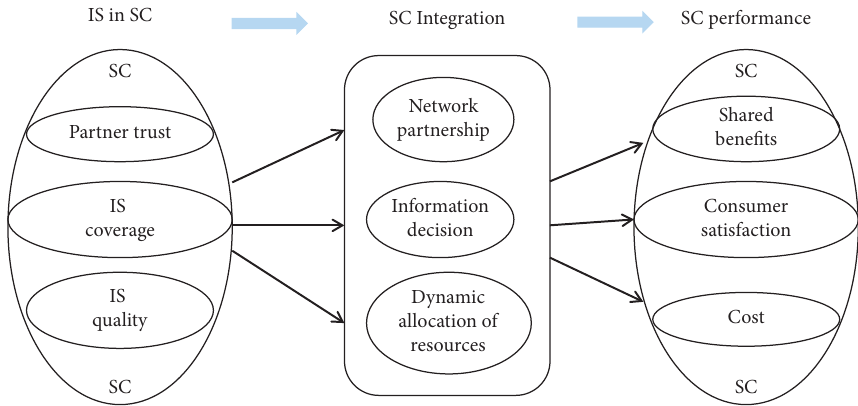
Figure 1: Theoretical model for the indirect influence of IS on SC